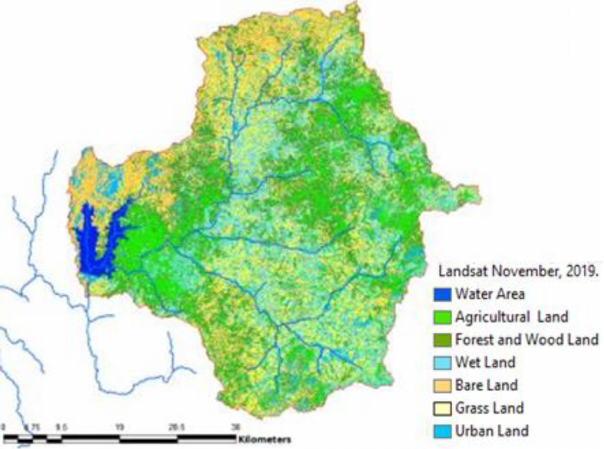
Figure 1. Land cover map showing changes within the GRC from 2010, the period after dam construction. Table 2. Hypothetical climate change scenarios.